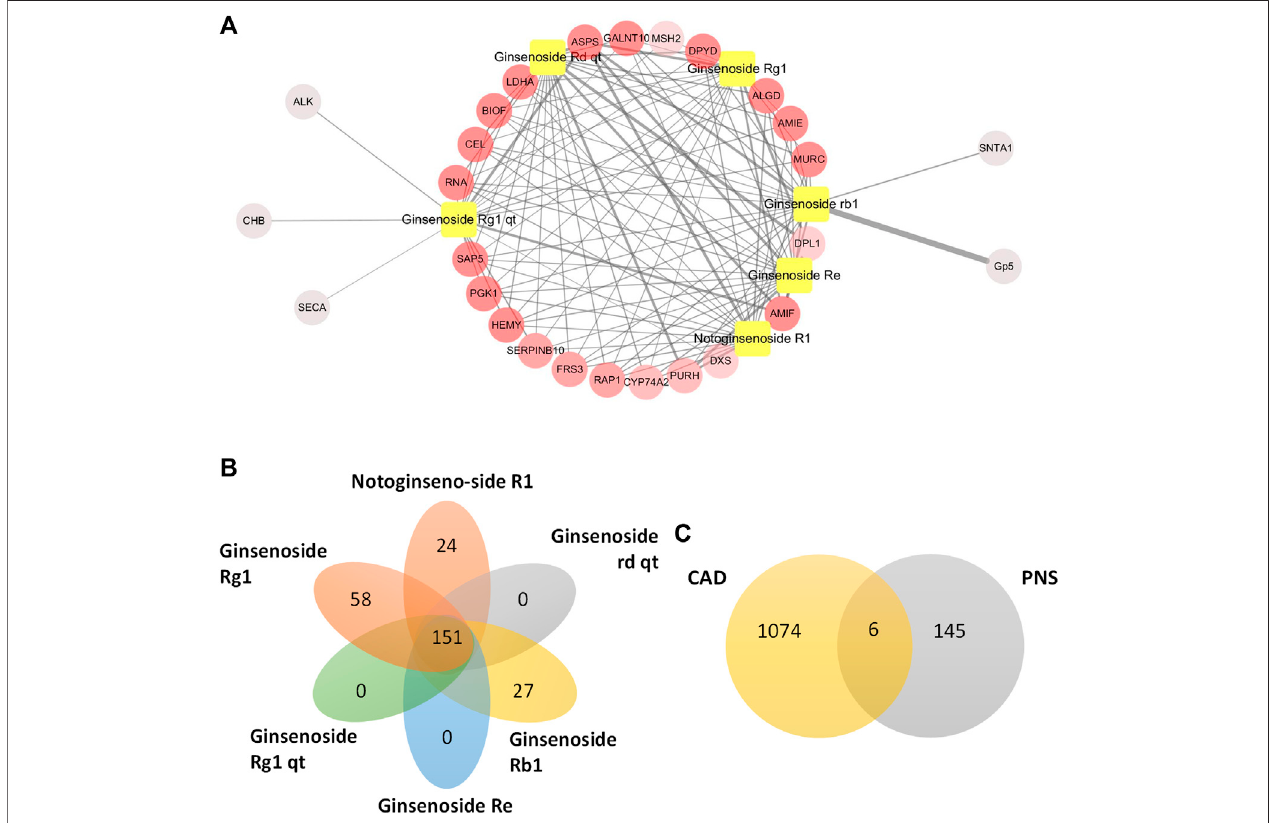
FIGURE 4 | Blood tests before and after treatment in the PNS and placebo groups. p < 0.05 and ** p < 0.01, signi fi cantly different from the PNS group before.